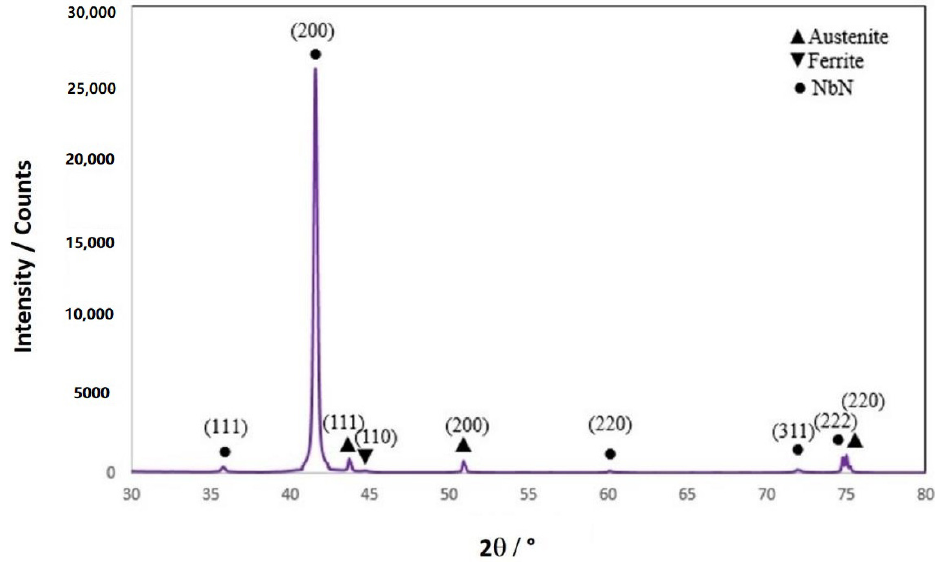
Figure 4. XRD pattern of Nb / NbN-HT coating deposited on 304 SS substrate at a high temperature.